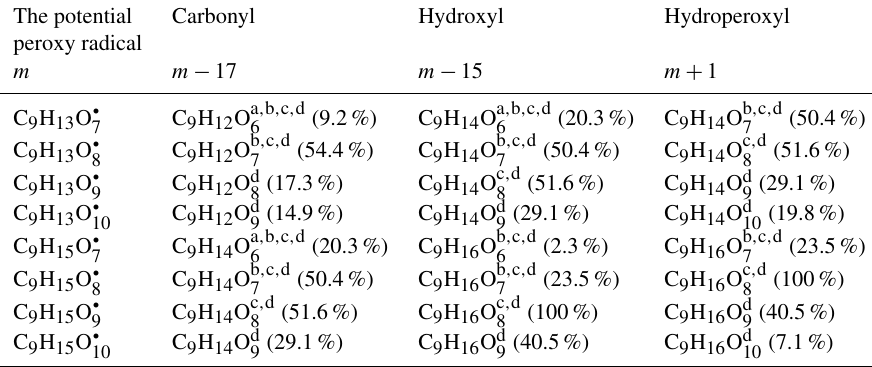
Table 2. Oxidation products of 1,2,4-TMB in categories of carbonyl, hydroxyl, and hydroperoxyl according to their molecular mass as well as the potential peroxy radicals. Numbers in the parentheses denote the relative intensity detected by the nitrate CI-APi-TOF in the OH- initiated oxidation of 1,2,4-TMB when that of the largest HOM signal (C 9 H 16 O 8 ) is arbitrarily set to be 100%. The relative intensity has been corrected with the relative transmission efficiency of the nitrate CI-APi-TOF.